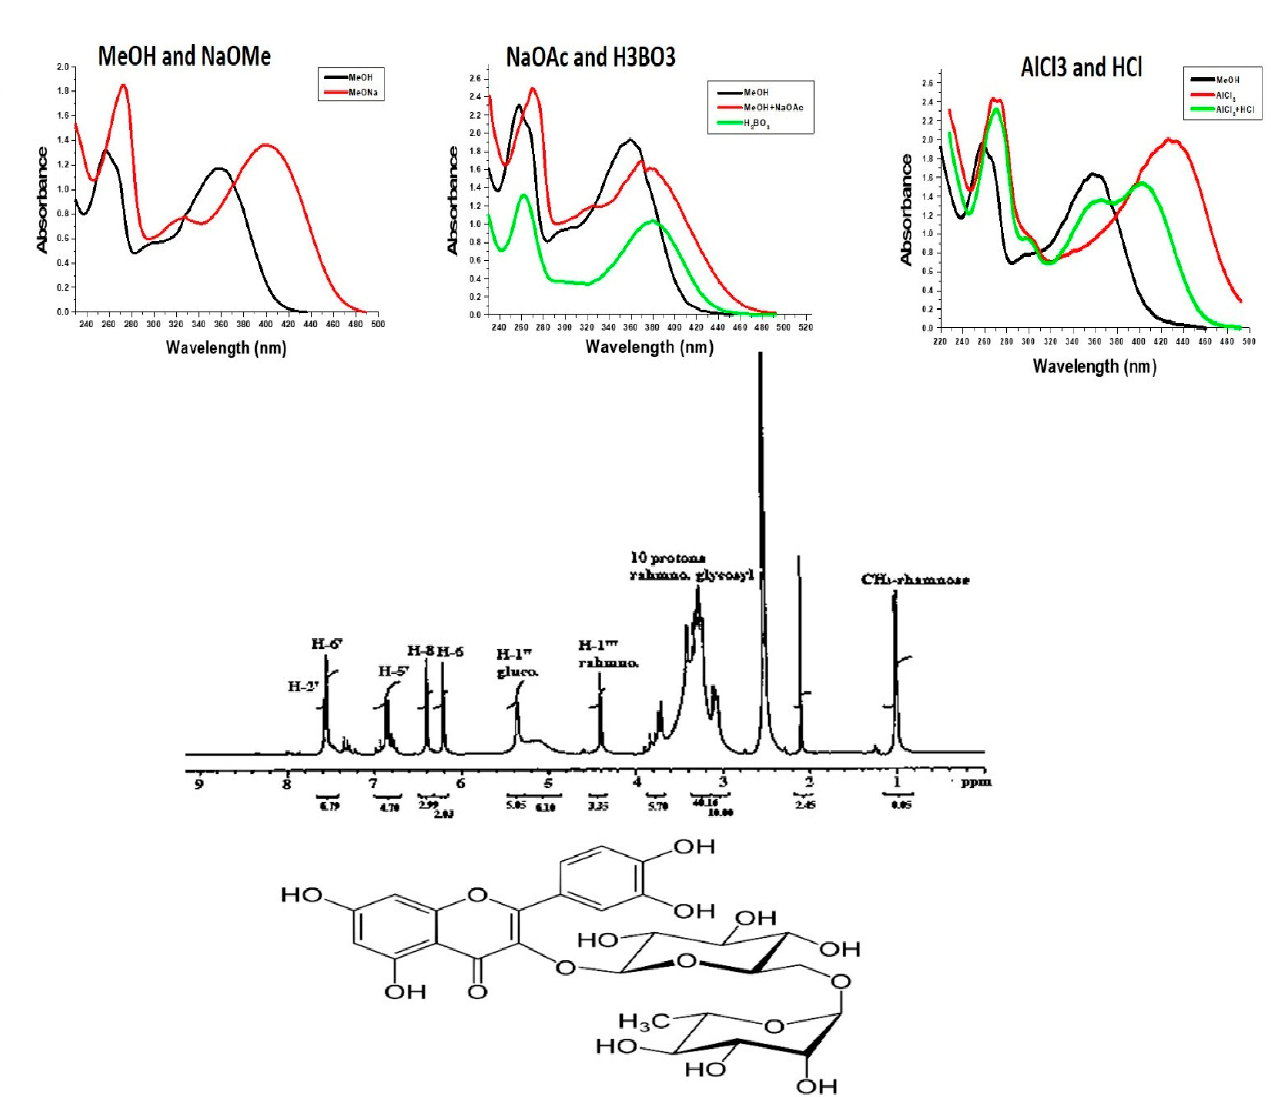
Figure 1. Identification of the bioactive compound. The compound rutin was identified according to the ( A ) UV spectrum in MeOH and NaOMe, NaOAc and H 3 BO 3 , AlCl 3 and HCl; ( B ) 1H-NMR spectrum of rutin. ( C ) Chemical structure of